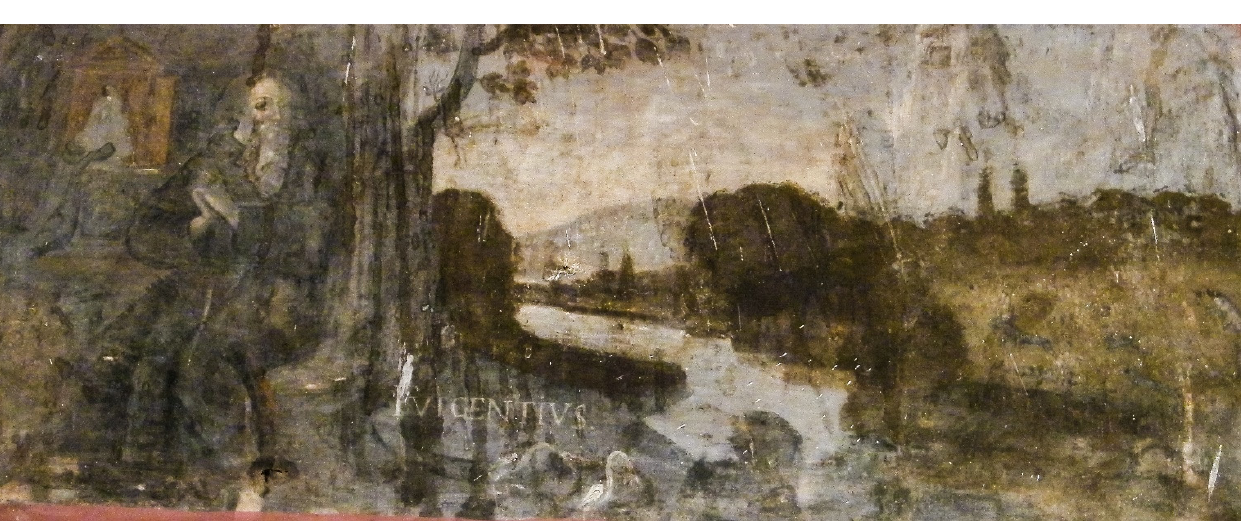
Figure 4. Unidentified artist, Fulgentius , Series of Anchorites, 17th century, oil on canvas, Convento de la Recoleta, Sucre, Bolivia. Credit line: Sebastian Ferrero.